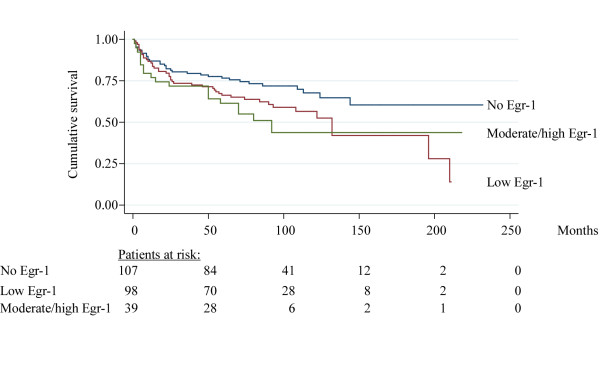
Kaplan-Meier plot. Kaplan-Meier survival curve illustrating correlation between Egr-1 score (frequency of Egr-1 positive cancer cell nuclei in tumor mass) and progression to stage T2-T4 bladder cancer. Information from 244 patients was included. P = 0.035, log rank test. Total number of events were 96, with 33 events in Egr-1 negative, 44 events in low Egr-1 and 19 invents in moderate/high Egr-1.